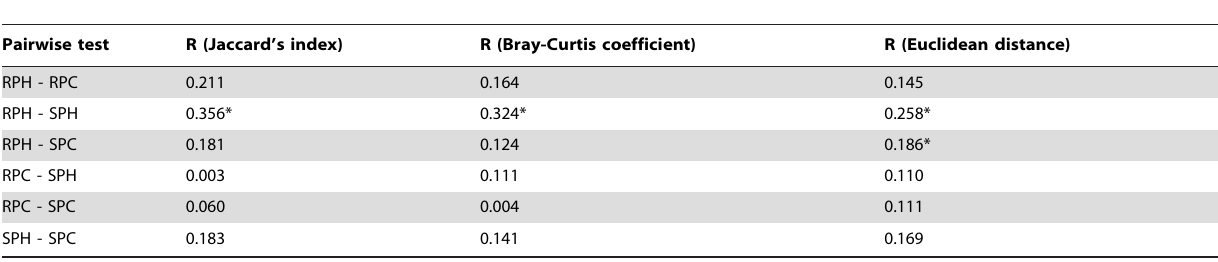
Table 5. ANOSIM pairwise test of EFC isolated from the four coffee plantations.